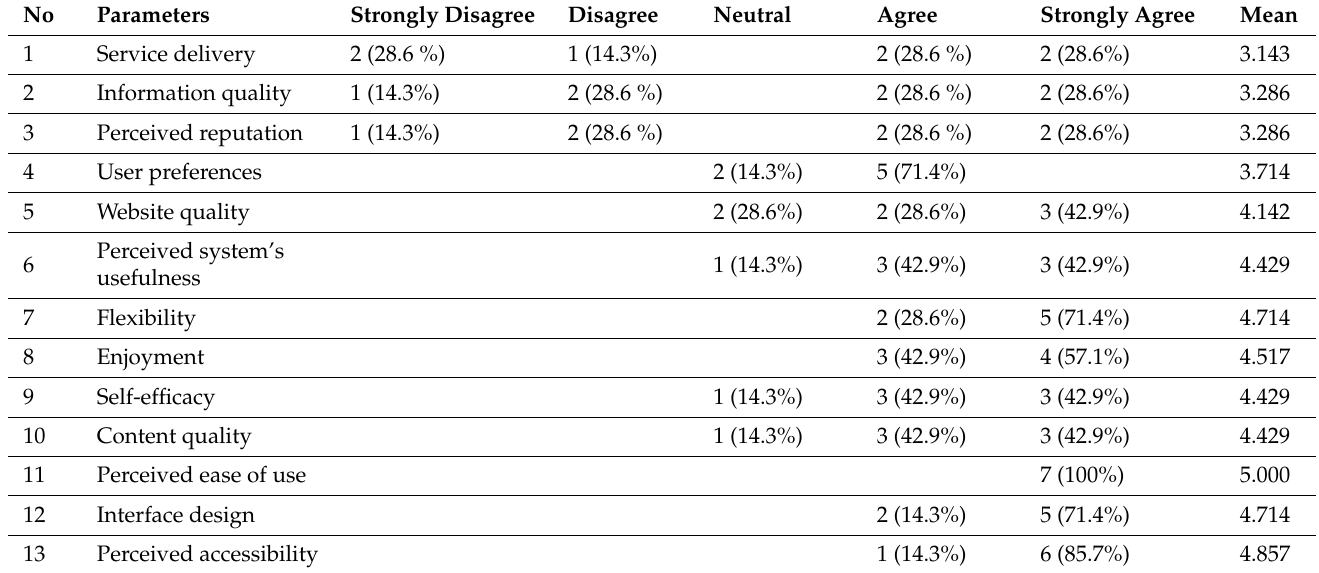
Table 3. Summary of parameters of iteration